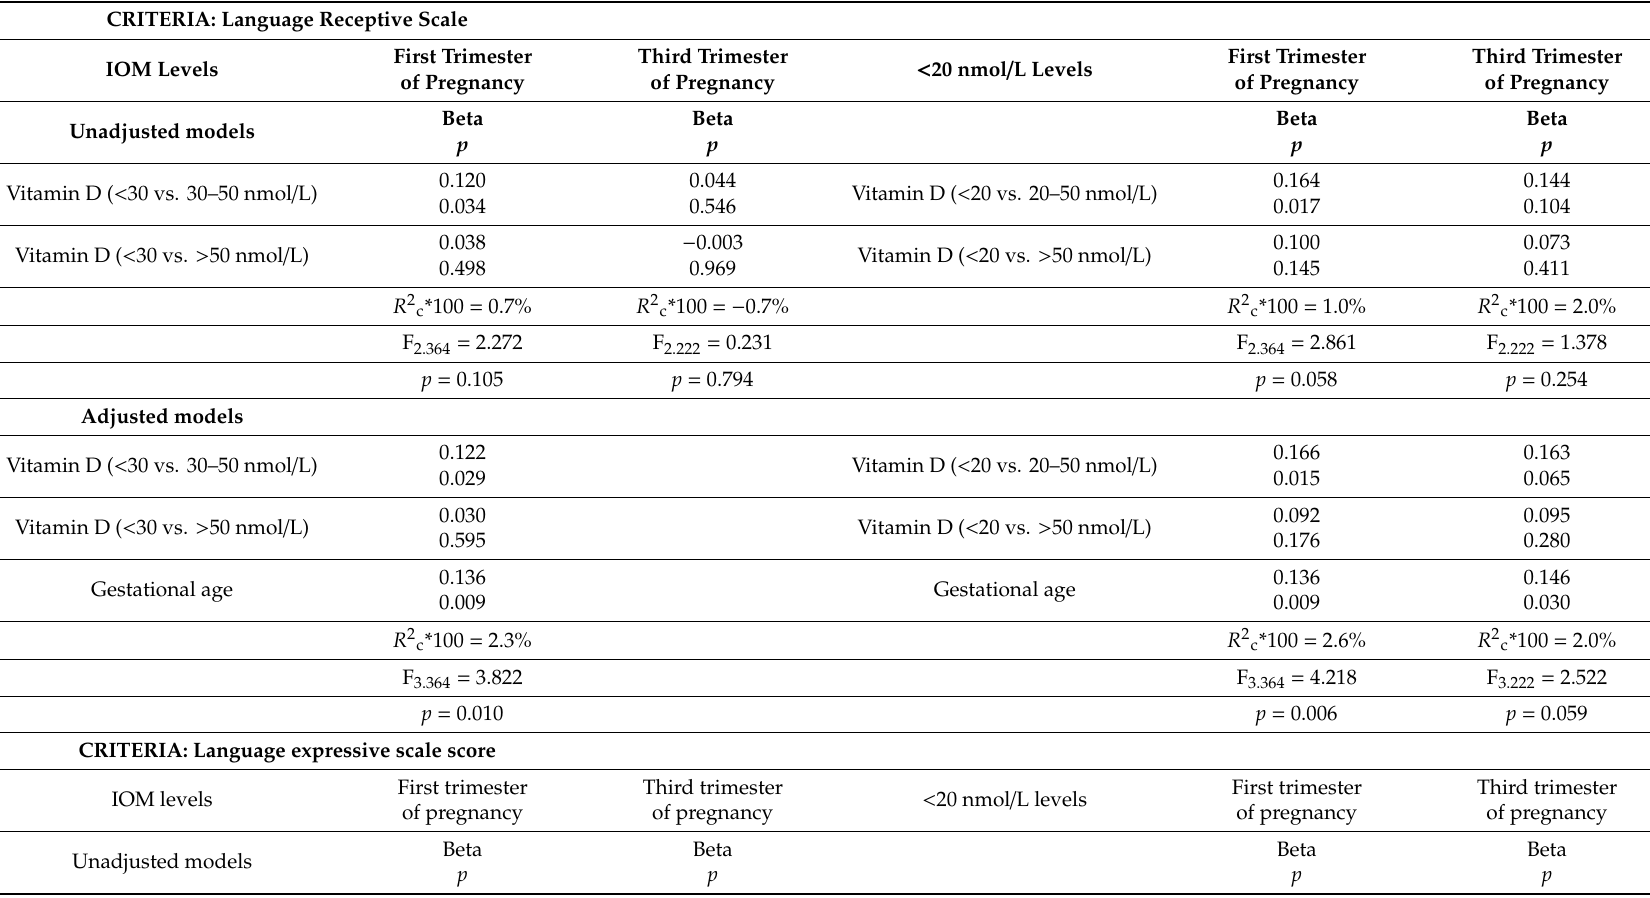
Table 5. Multiple linear regression models to explore the relationship between vitamin D during pregnancy (first and third trimester) and the Bayle Scales of Infant Development-III (BSID-III) language scores at 40 days